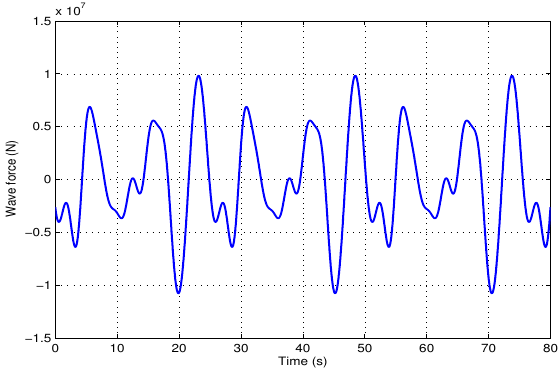
Figure 2. The irregular wave force.